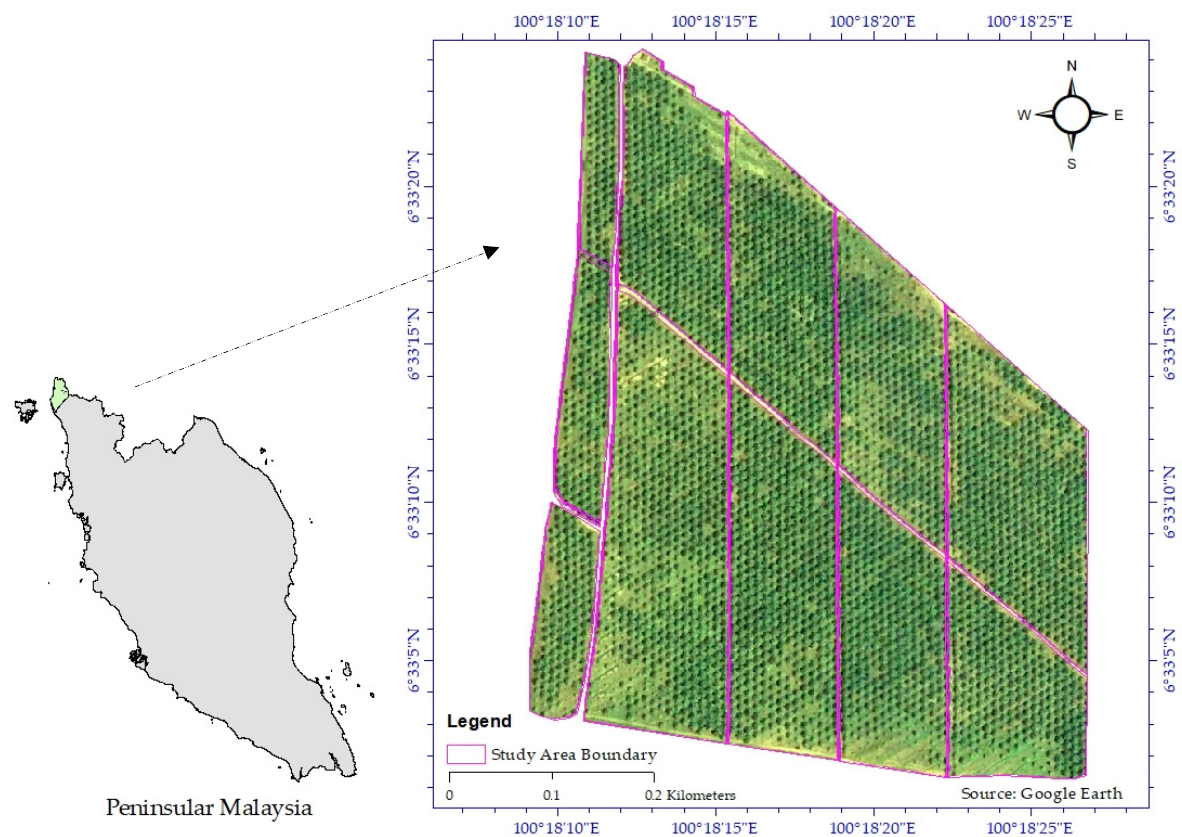
Figure 1. The oil palm cultivated area within the Chuping district in Perlis, Malaysia. Table 1. Meteorological information of study